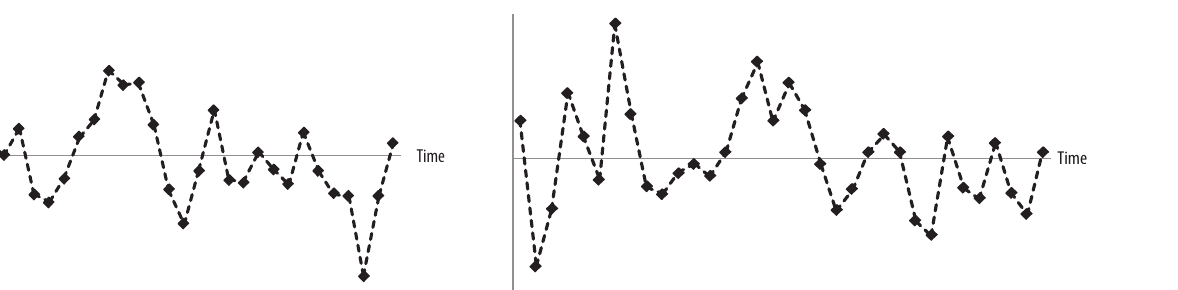
Fig. 7. Residual plot of the model (4a) indicates no/ weak autocorrelation